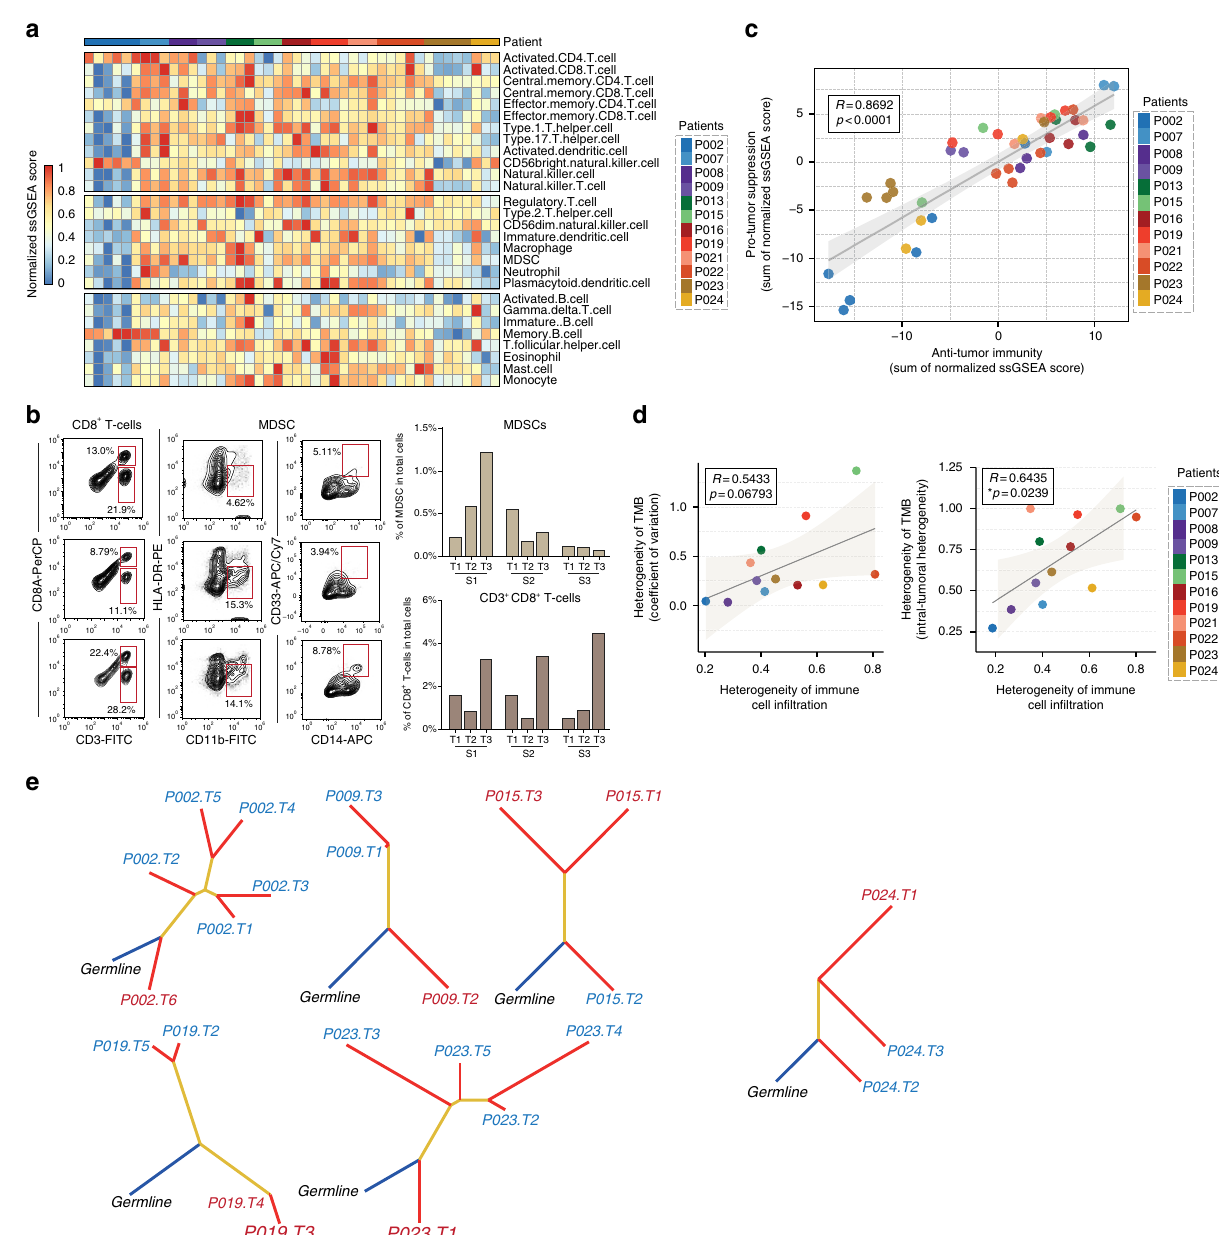
Fig. 3 Correlation of TMB and immune cell in fi ltration heterogeneity. a Single-sample gene set enrichment analysis identifying the relative in fi ltration of immune cell populations for 44 NSCLC tumor samples with available RNA-sequencing data. The relative in fi ltration of each cell type is normalized into a z - score. b Validation by fl ow cytometry. Samples were collected separately from the sequenced batch. c Correlation between in fi ltration of cell types executing anti-tumor immunity (ActCD4, ActCD8, TcmCD4, TcmCD8, TemCD4, TemCD8, Th1, Th17, ActDC, CD56briNK, NK, NKT) and cell types executing pro-tumor, immune suppressive functions (Treg, Th2, CD56dimNK, imDC, TAM, MDSC, Neutrophil, and pDC). R coef fi cient of Pearson's correlation. The shaded area represents 95% con fi dent interval. d Scatterplot showing correlation between heterogeneities of total mutation burden and immune cell in fi ltration. An average pairwise correlation coef fi cient was calculated to quantify the divergence of immune cell in fi ltration, and presented as 1-value for clear visualization. Higher values, heterogeneous immune cell in fi ltration; lower values, homogeneous immune cell in fi ltration. The variation in genomic mutations was determined by either intratumoral heterogeneity (ITH) or coef fi cient of variance (CV). Higher values, heterogeneous; lower values, homogeneous mutation pattern. R coef fi cient of Pearson's correlation. e Phylogenetic trees generated by a parsimony ratchet approach based on the distribution of all detected mutations are shown for patients with heterogeneous immunological status; trunk and branch lengths are proportional to the number of non-synonymous mutations acquired. Red label, samples in hot area; blue label, samples in cold